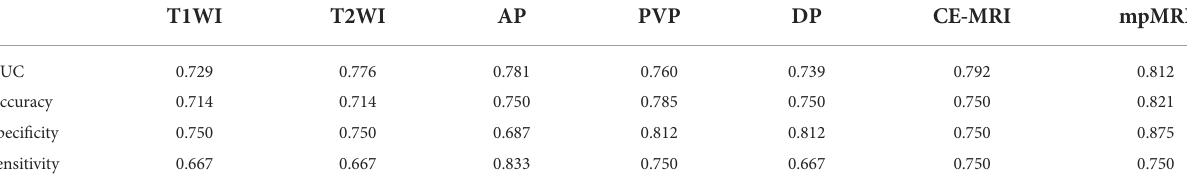
TABLE 3 Prediction performance of each radiomics model in validation cohorts.